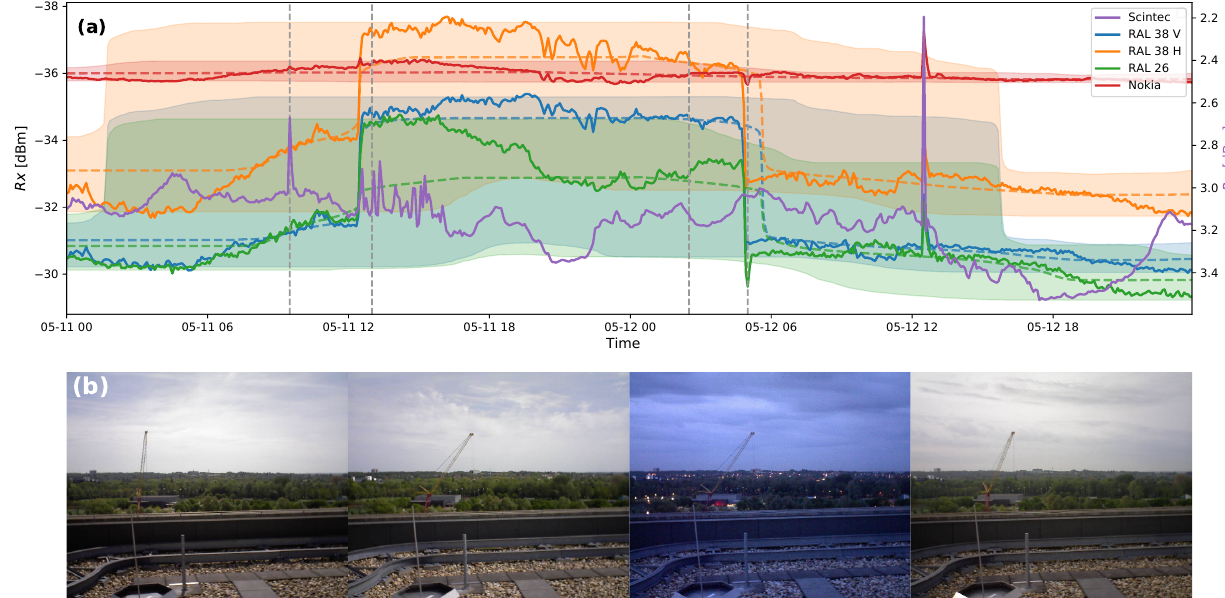
Figure 15. Time series of an event on 11 May 2015. (a) Received power levels at the detectors as solid lines, with the reference levels (median over dry periods in a 24h moving window) indicated by dashed lines. The 5th and 95th percentile power levels over dry periods in a 24h moving window are indicated by the coloured shading. (b) Images from the time-lapse camera at the location of the receiving antennas aimed along the link path. The times at which these images were captured is indicated by the vertical dotted